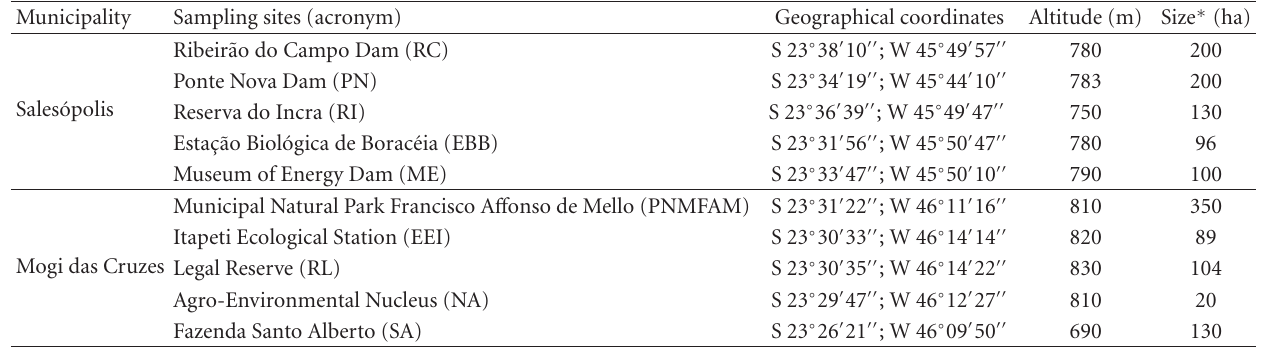
Table 1: Locations of sampling sites in southeastern S˜ao Paulo state,